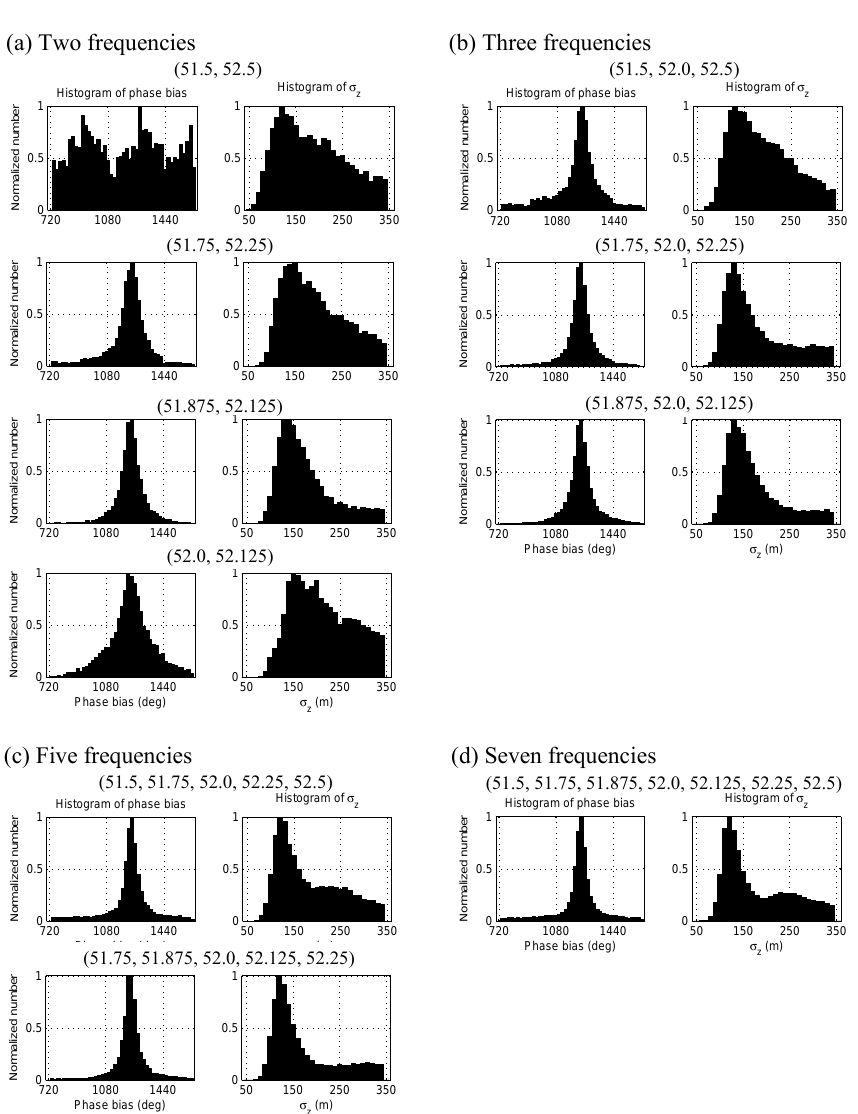
Figure 3. Histograms of the calibrated parameters for different sets of transmitter frequencies, with the radar data collected from the second receiving channel (Rx_2) in Fig. 1. The values quoted at the title locations are the transmitter frequencies; the unit is MHz.